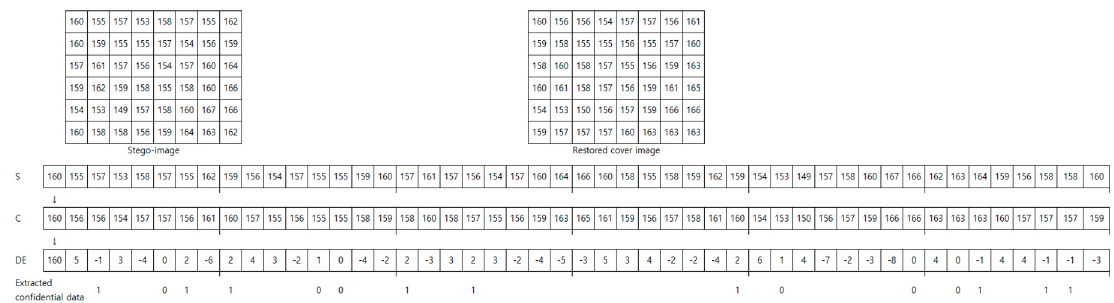
Figure 4. An example of data embedding using the APD technique. Appl. Sci. 2020 , 10 , x FOR PEER REVIEW